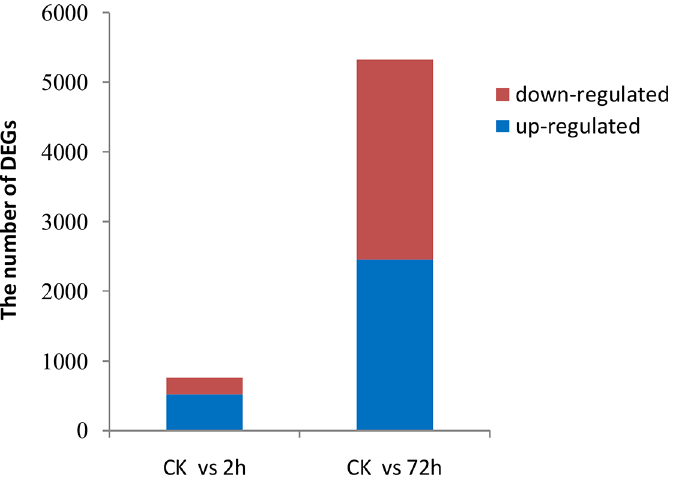
Fig 7. Number of DEGs between normal condition and cold treatments.